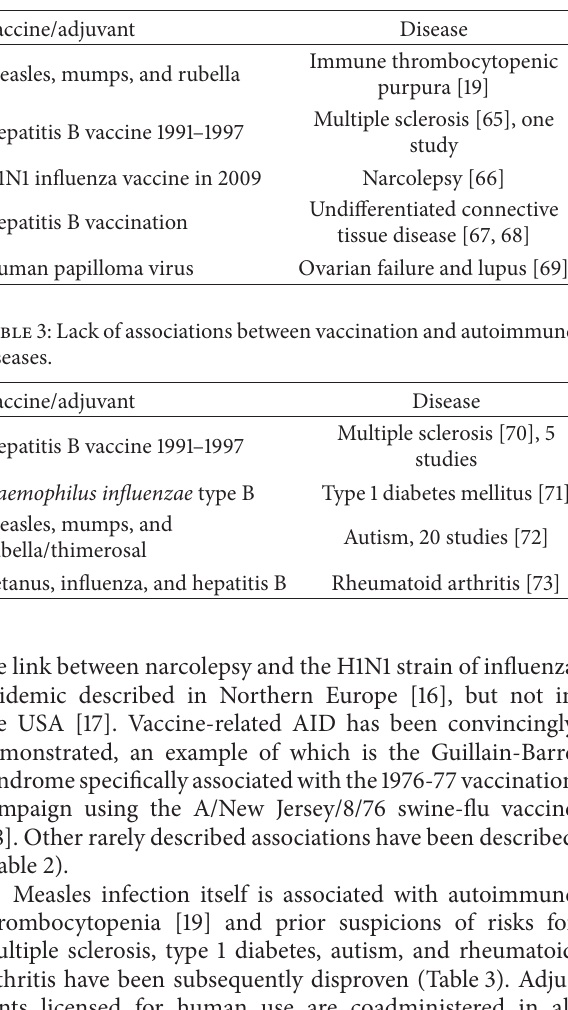
Table 2: Reported associations between vaccination and autoim- mune diseases.